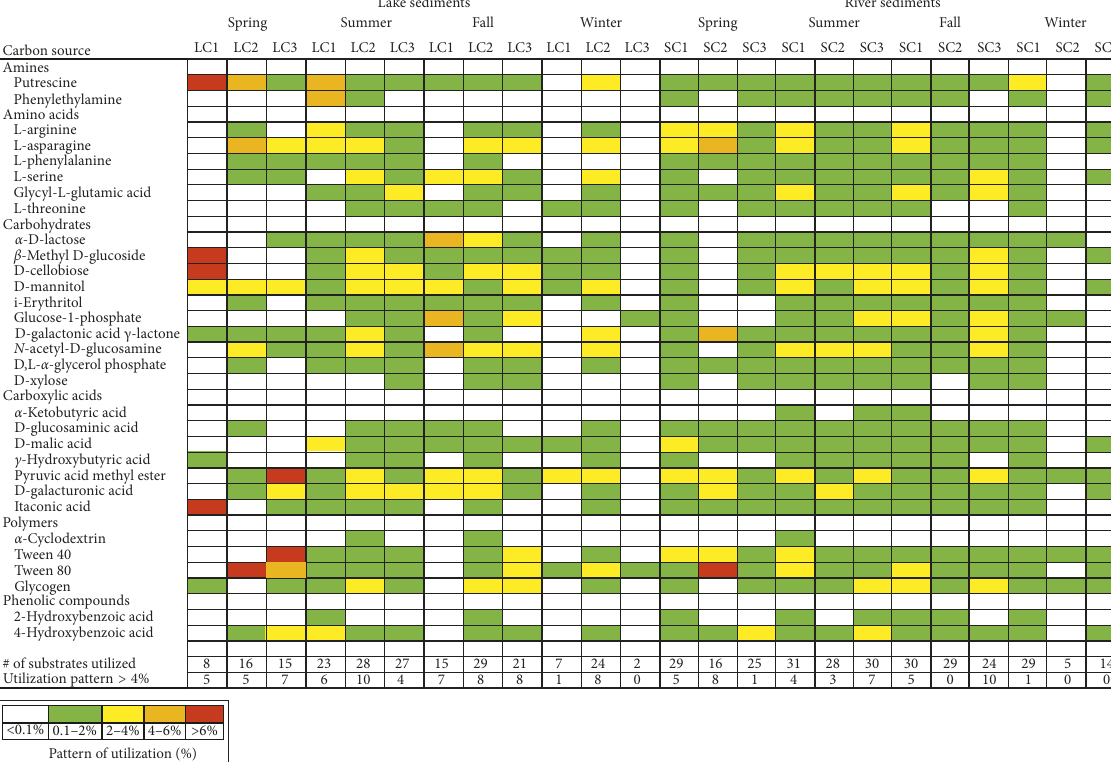
Figure 4: Pattern of utilization (based on mean AWCD) of the 31 carbon substrates for the lake and river sediments across sites and seasons. Shading in the boxes indicates the range of percentage absorbance of the total absorbance of the plate. Values are as follows: white, < 0.1%; green, 0.1–2%; yellow, 3-4%; orange, 5-6%; red, > 6%. The number of substrates with > 4% absorbance for each sampling site is indicated below each